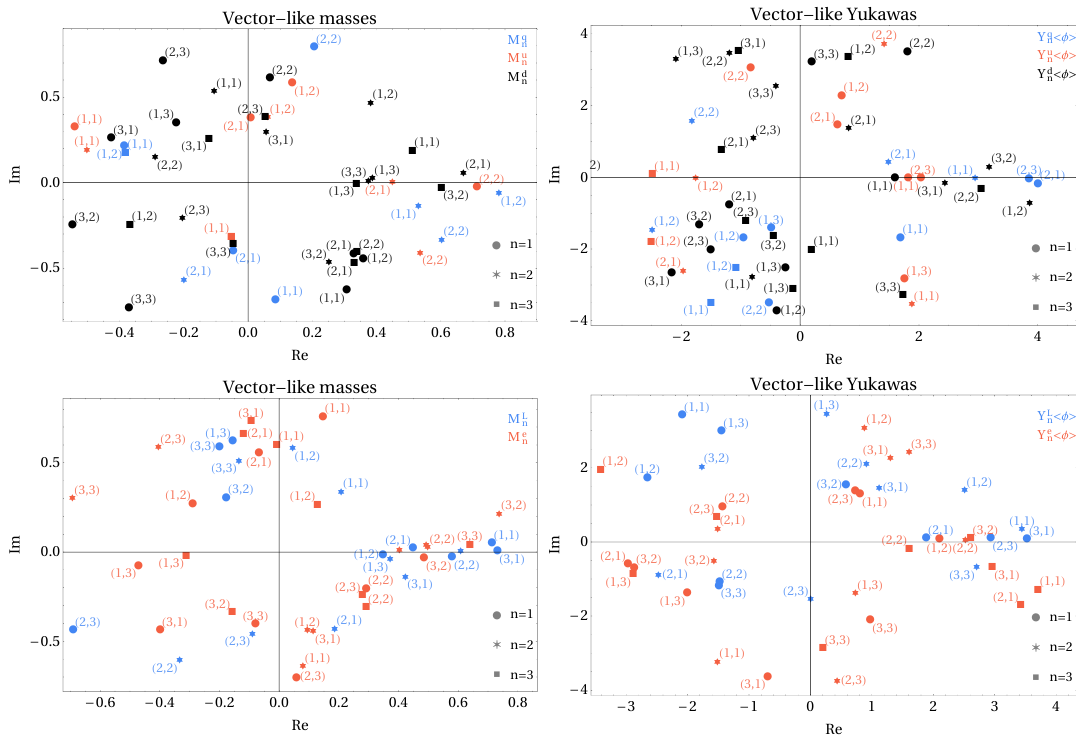
Figure 20 . Numerical values for the entries in the vector-like fermion mass matrices for the coupled FN chain benchmark in the case of quarks (top) and leptons (bottom).